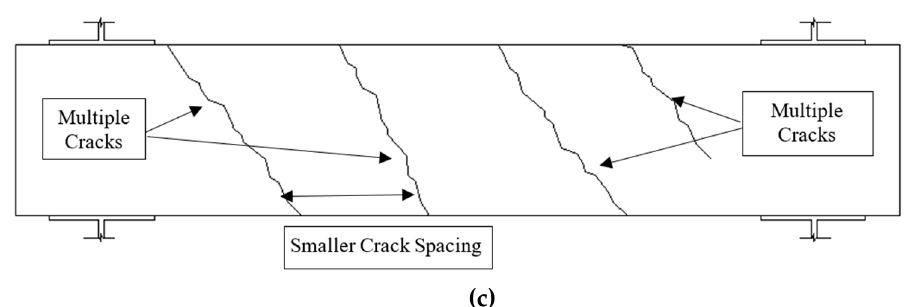
Figure 4. Cracking patterns based on reinforcement types: ( a ) fibre only reinforcement; ( b ) conventional reinforcement only; and, ( c ) hybrid fibre and conventional reinforcement.